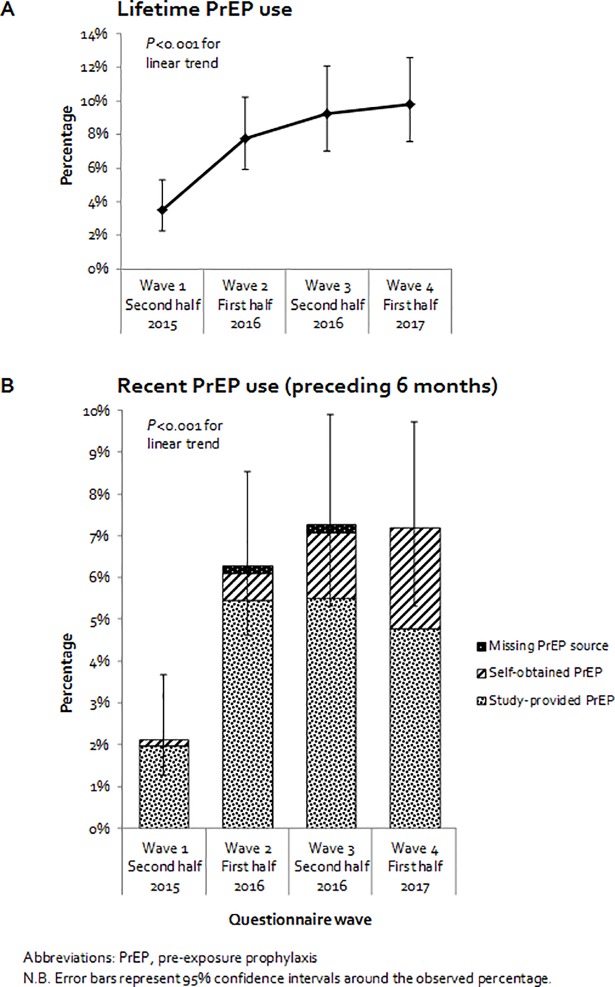
Reported lifetime and recent PrEP use among MSM participating in the Amsterdam Cohort Studies between 2015–2017 (four 6-montly waves of questionnaires).